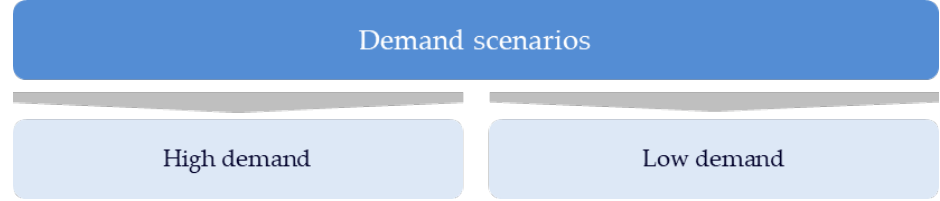
Figure 14. Mobility demand scenarios.